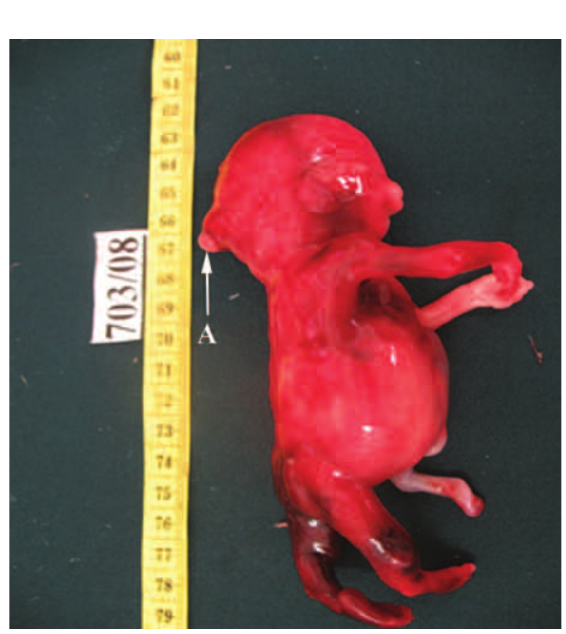
Figure 1. Occipital encephalocele. A – Occipital